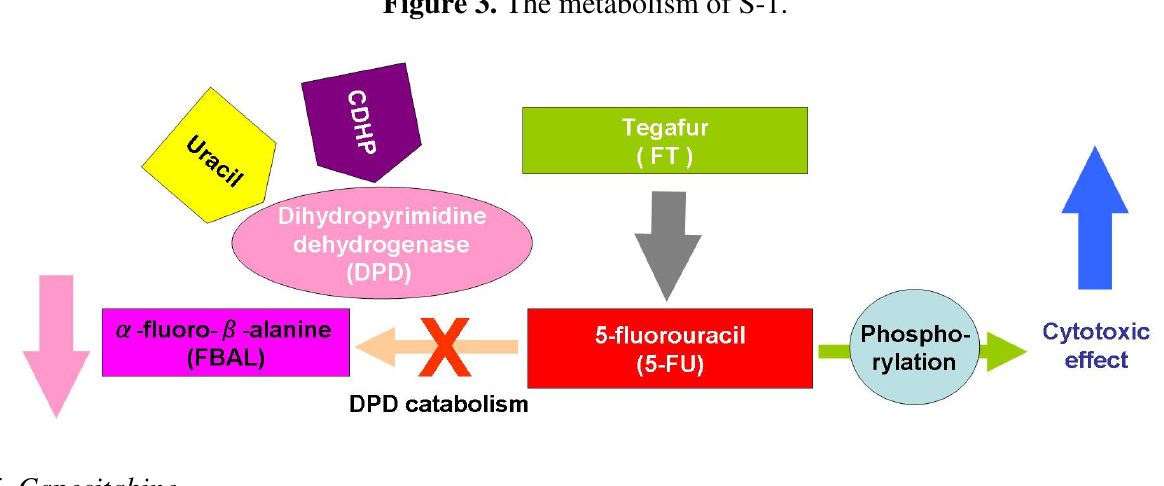
Figure 3. The metabolism of